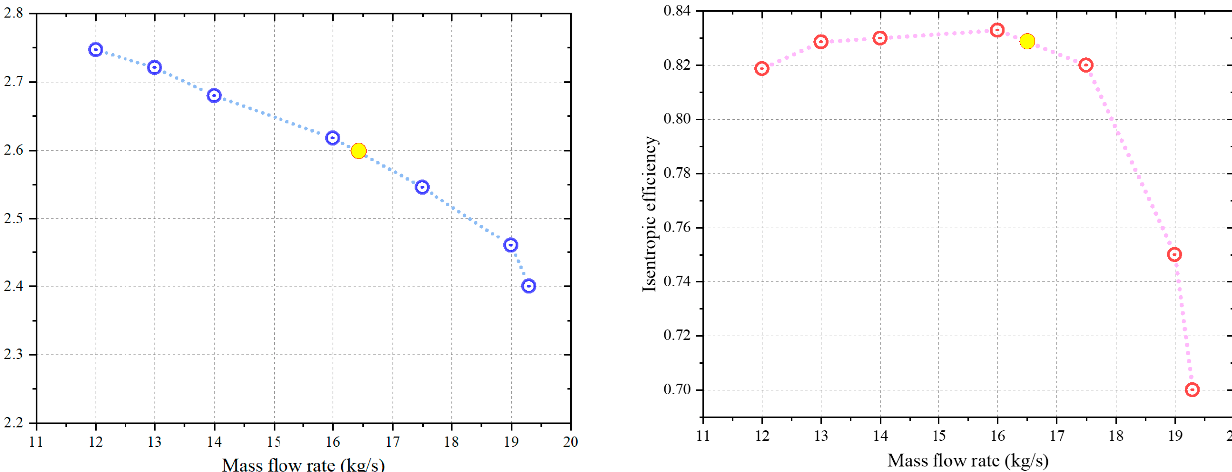
Figure 2. Distribution of the semi-open impeller. ( a ) Beta distribution, ( b ) Thickness distribution.